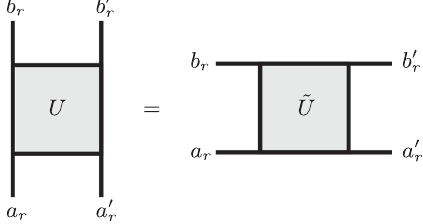
.FIG. 7. Components U b of the q 2 × q 2 unitary matrix U , r b 0 r ;a r a 0 r ˜ U q 2 × q 2 nonunitary matrix ˜ U . and components a r b r ;a 0 r b 0 r of the Time runs vertically and space horizontally. Here, U acts in the first half-step of the Floquet operator, so it describes the evolution Þ . Where U acts on the state of a pair of from time step r to ð r þ 1 2 ˜ U sites ð x; x þ 1 Þ at time r , acts on the state of site ( x þ 1 ) at Þ times ð r; r þ 1 2